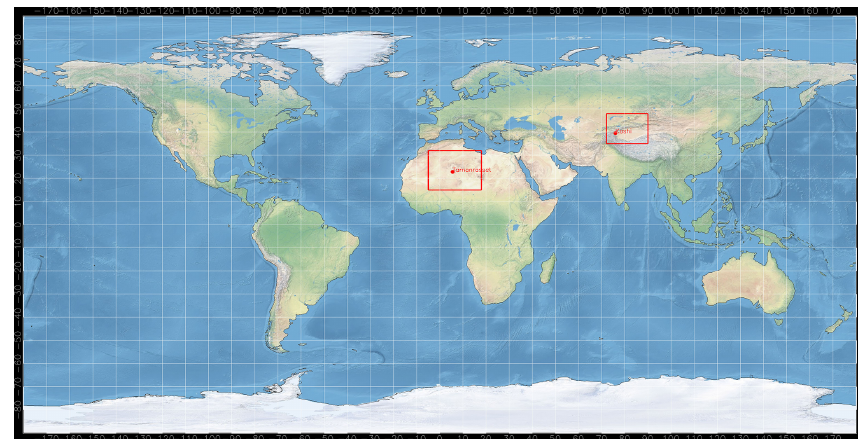
Figure 2. The research regions and dust storms viewed by MODIS AQUA on 11 March and 9 April 2019.